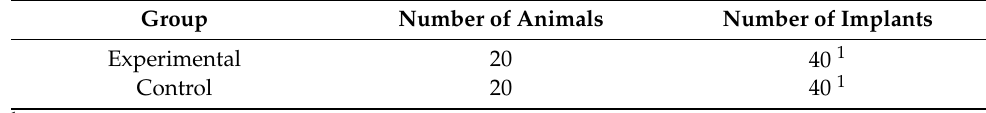
Table 1. The number of animals and